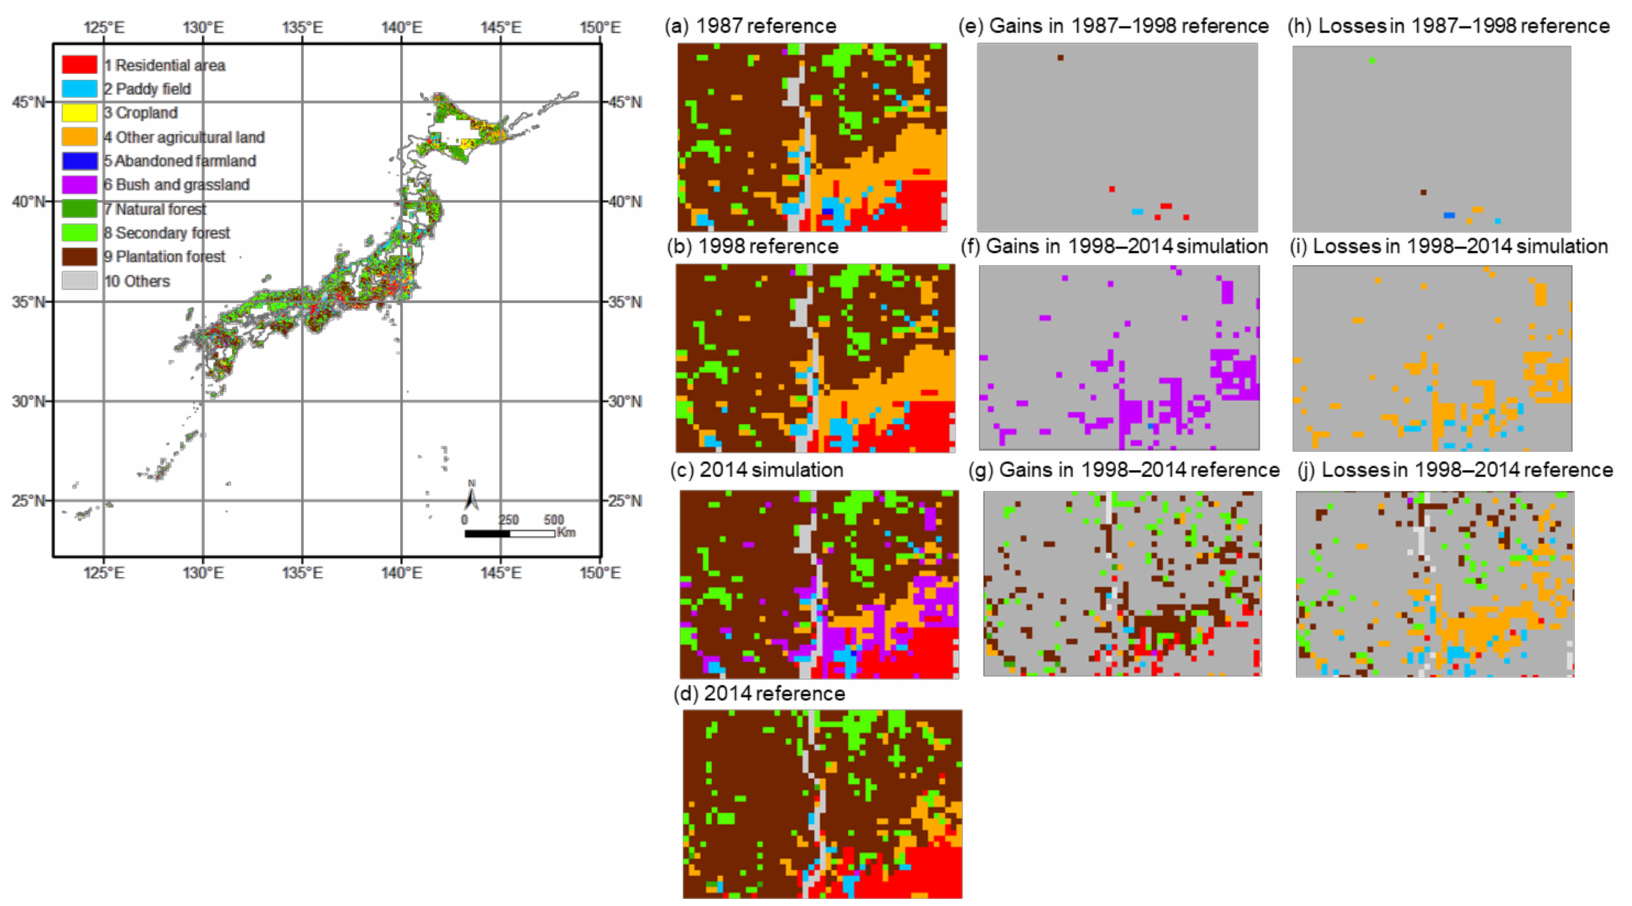
Figure 1. Entire land-use map in 2014 (left) and examples of reference maps and changes during two time intervals: reference map in 1987 ( a ); reference map in 1998 ( b ); simulation map in 2014 ( c ); reference map in 2014 ( d ); and gains ( e – g ) and losses ( h – j ) of each land use category during the calibration (1987–1998), simulation (1998–2014), and validation (1998–2014) time intervals. Each color shows the changes in land-use, and the grey color shows persistence, which indicates that a land-use category remained the same during a time interval ( e – j